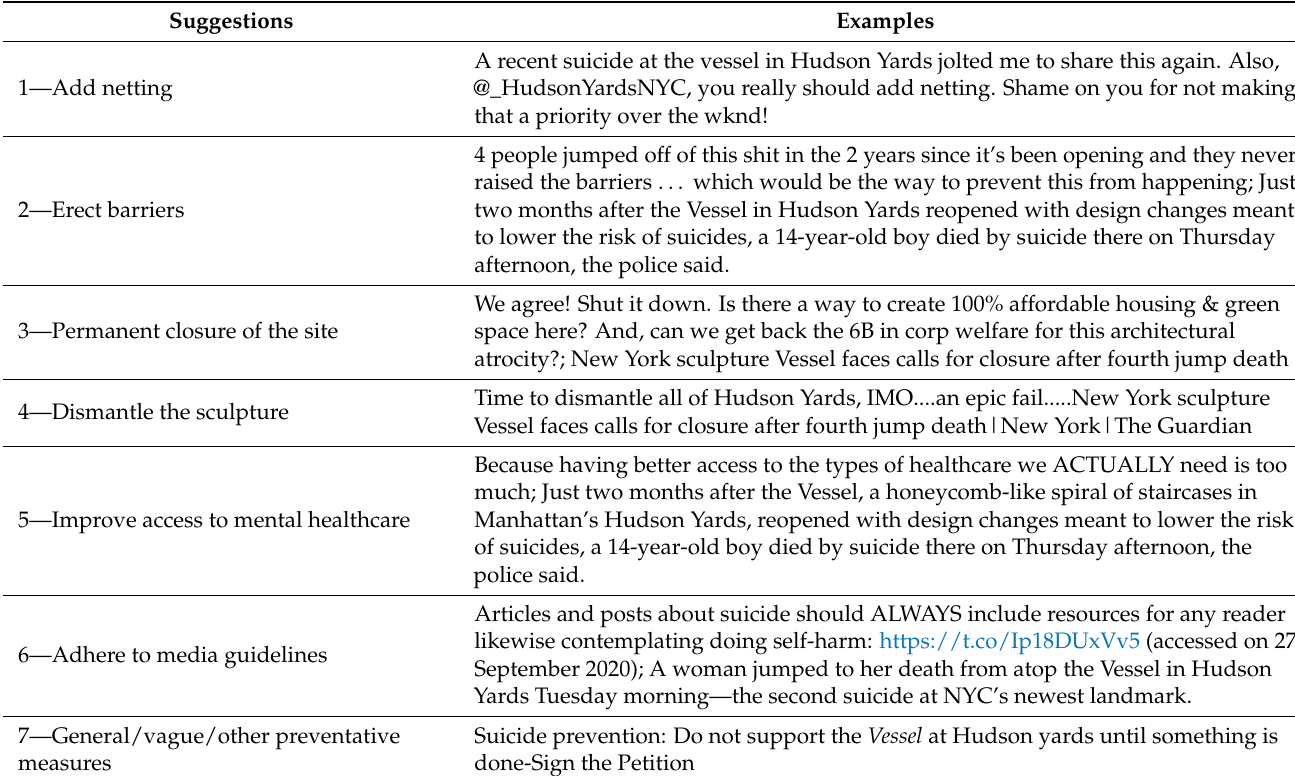
Table A2. Thematic analysis codebook of the tweets from Theme 6, ‘suggestions for suicide preven- tative measures’.